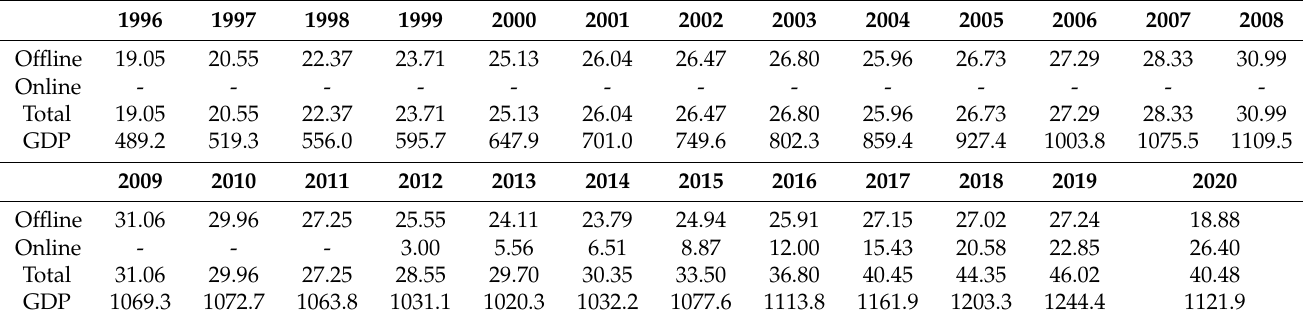
Table 1. Gambling spending (billions of